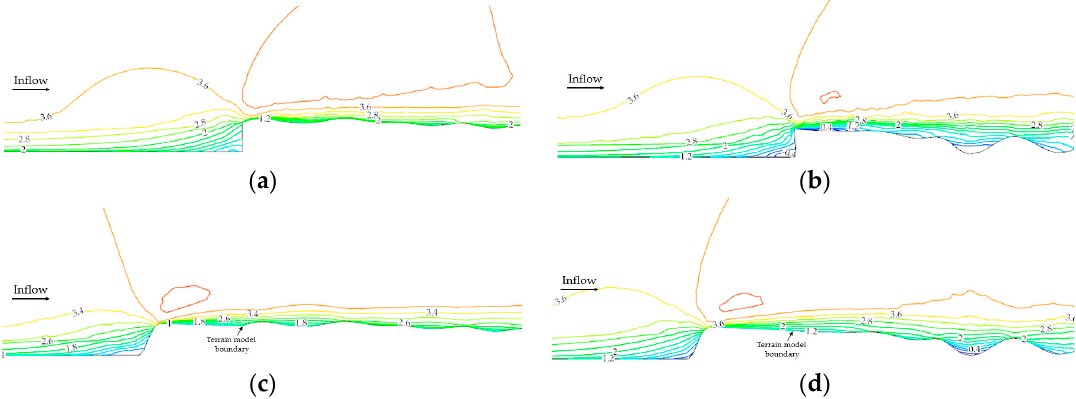
Figure 10. Wind speed distribution along the inflow direction near the inlet of the terrain model without or with improved BTS from CFD simulation (unit: m / s). ( a ) Case 1 without BTS; ( b ) Case 2 without BTS; ( c ) Case 1 with BTS; ( d ) Case 2 with BTS.